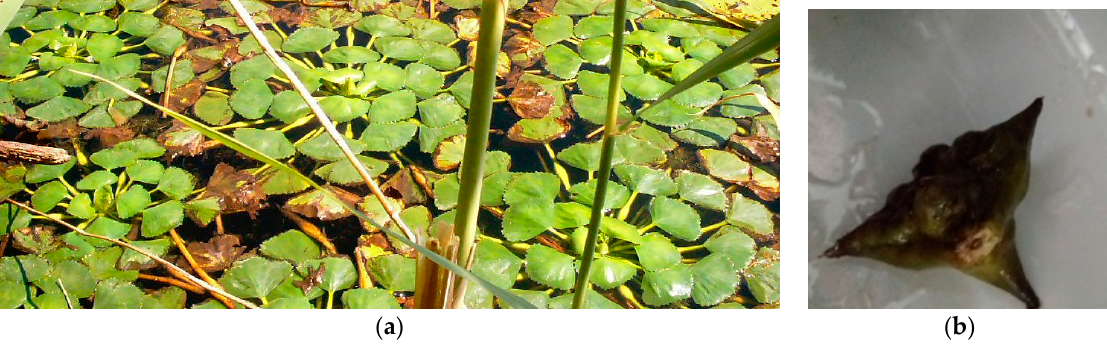
Figure 3. Sampling location of Trapa natans ( a ) (near to settlement Vranjina, Skadar Lake) and fruit ( b ).